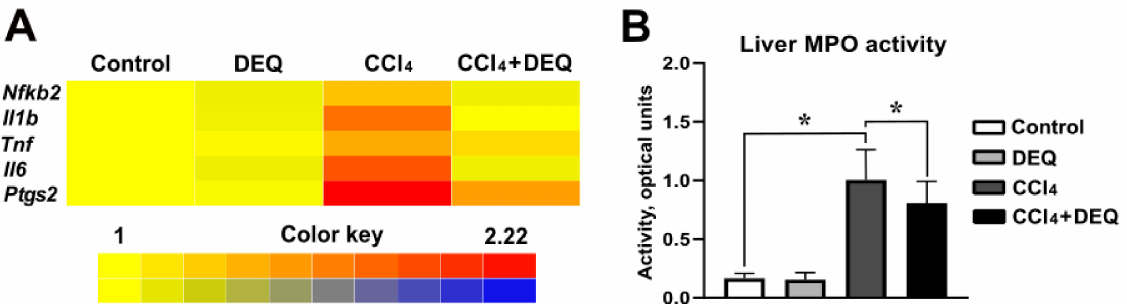
Figure 3. Effect of DEQ administration on hepatic Nfkb2 , Il1b , Tnf , Il6 , and Ptgs2 mRNA levels, and myeloperoxidase (MPO) activity in rats with CCl 4 -induced liver injury. DEQ treatment downregulated expression of pro-inflammatory genes ( Nfkb2, Il1b , Il6 , Tnf , and Ptgs2) (Figure 3A, p < 0.05), and decreased myeloperoxidase (MPO) activity in rats with CCl 4 -induced liver injury (Figure 3B, * p < 0.05). Data are expressed as mean ±